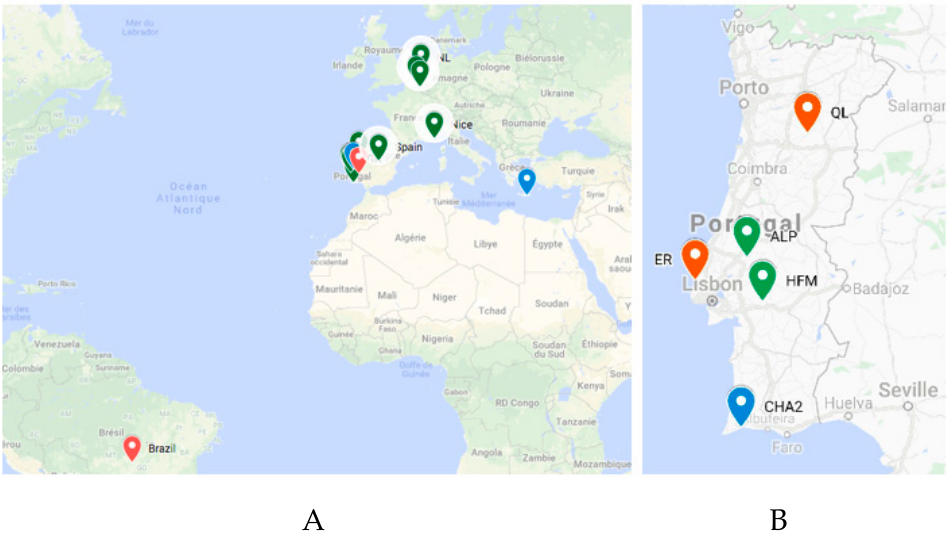
Figure 8. Map representing the origin of spider mites’ populations worldwide ( A ) and in Portugal (boxed) ( B ) where the prevalence of TuaDV has been assayed by PCR and sequenced (full or partial genome) and in Portugal ( B ). T. urticae (green), T. cinnabarinus (blue), and T. evansi (red). Maps were made from maps.google.com.